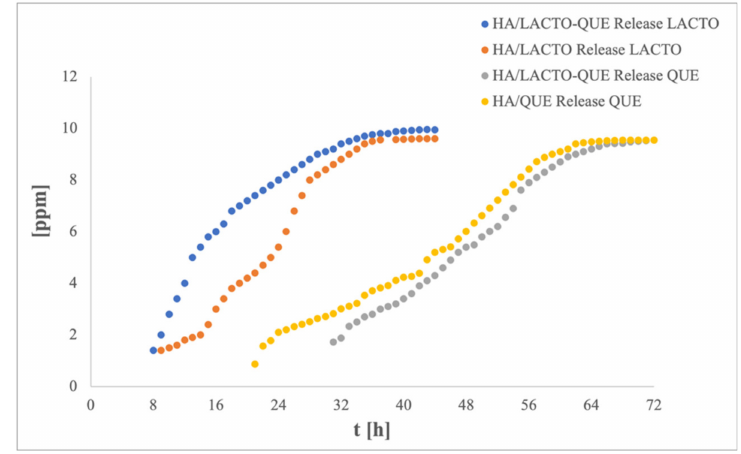
Figure 3. Release profile of QUE and LACTO from HA complexes.